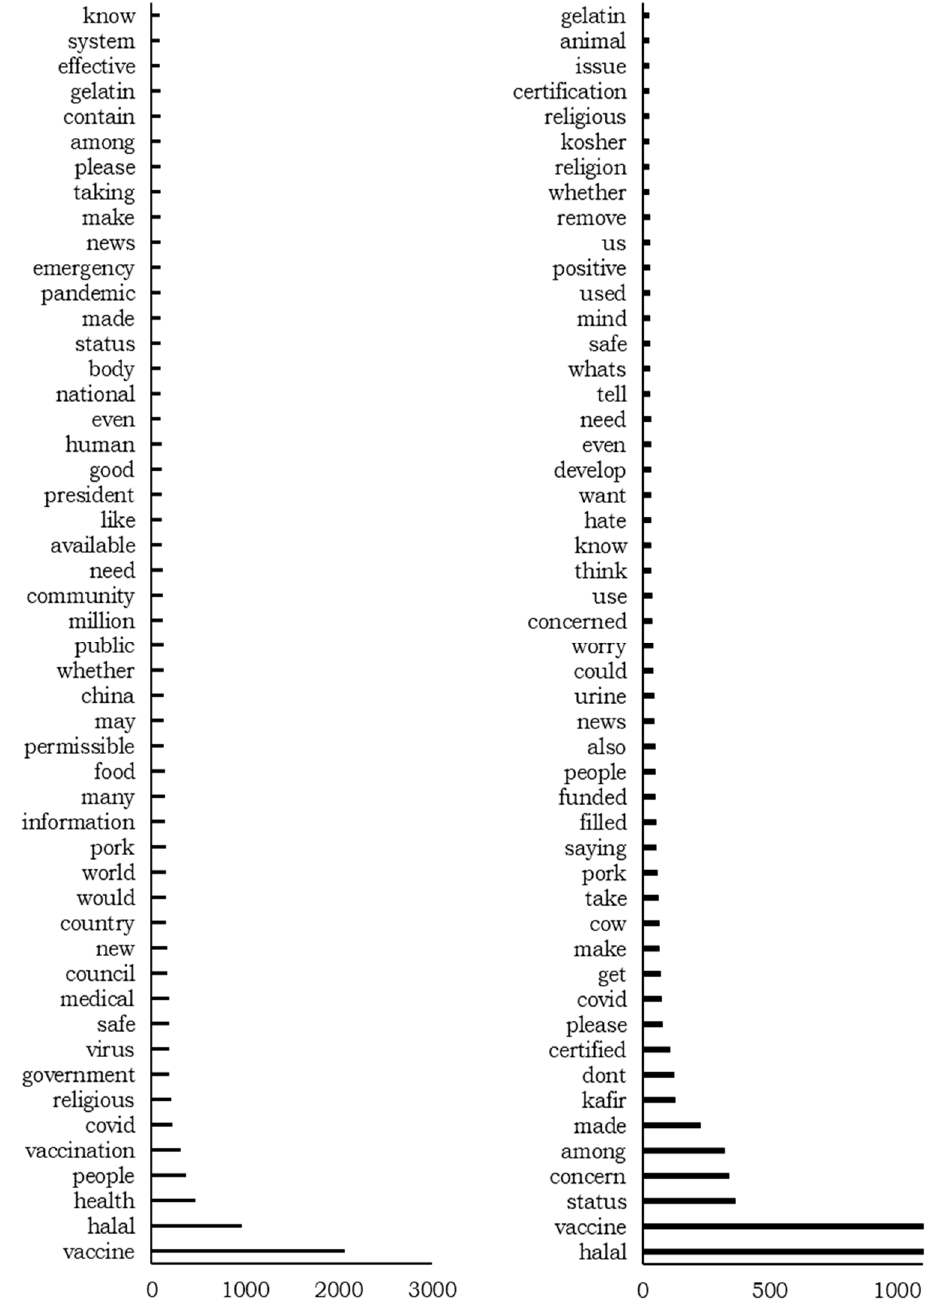
Figure 11. Top 50 most frequent words in Facebook ( left ) and Twitter ( right ) data for fear.